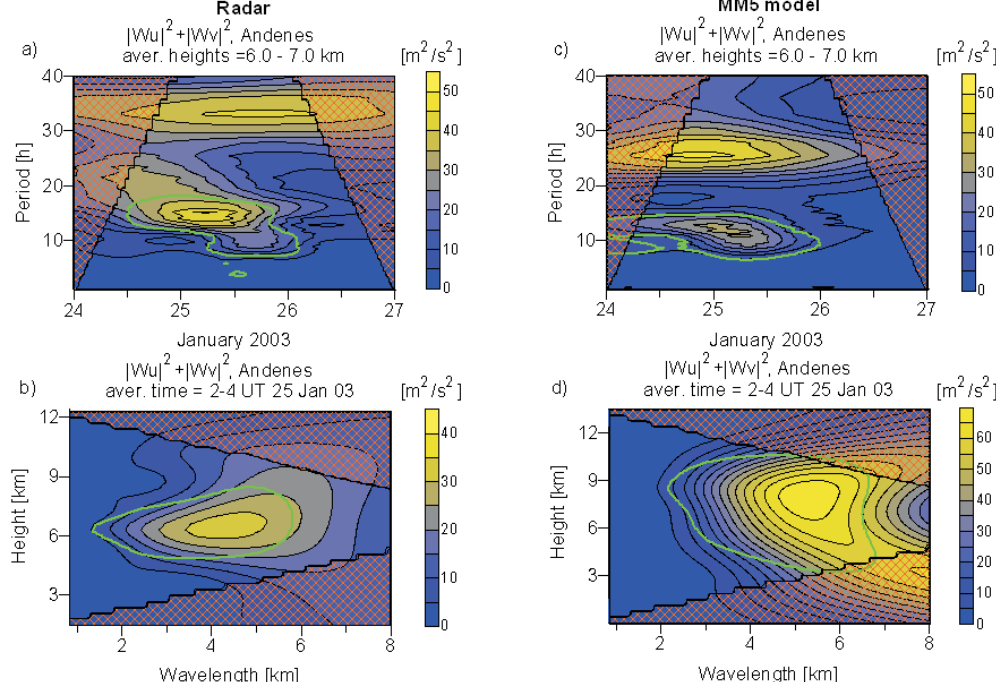
Fig. 6. The wavelet spectra of horizontal winds from ALWIN radar measurements (a, b) and MM5 model output (c, d) . The upper panel (a, c) shows the Morlet wavelet transform of the time series averaged over the altitude ranges 6–7km. The lower panel (b, d) shows the averaged in time Paul wavelet transforms of vertical profiles of horizontal winds. The bold green line outlines the region with 95% significance level, the red shaded area indicates the zones where boundary effects appear.